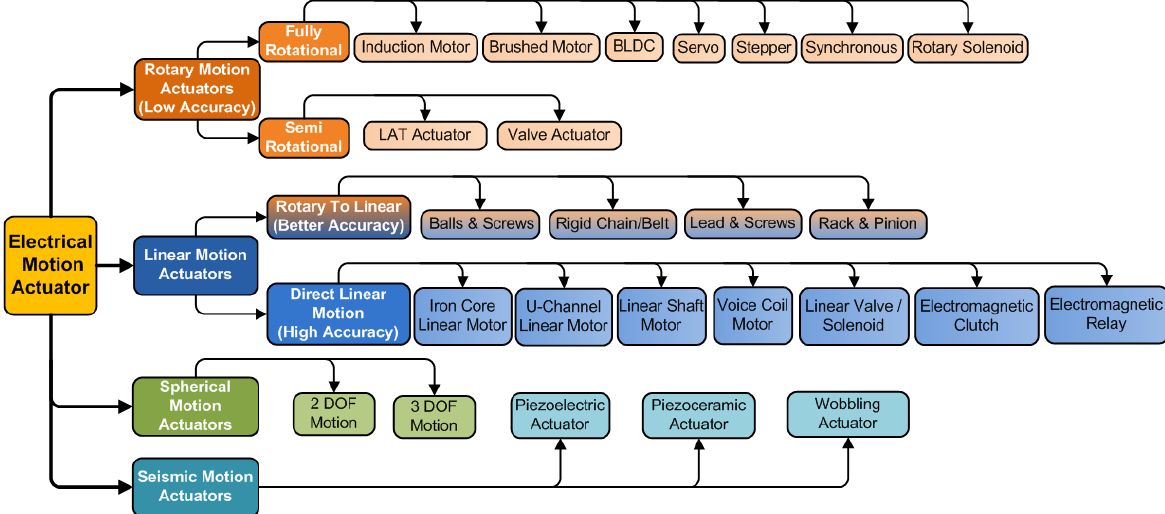
Figure 1. Active electric actuators according to their motion used in the renewable